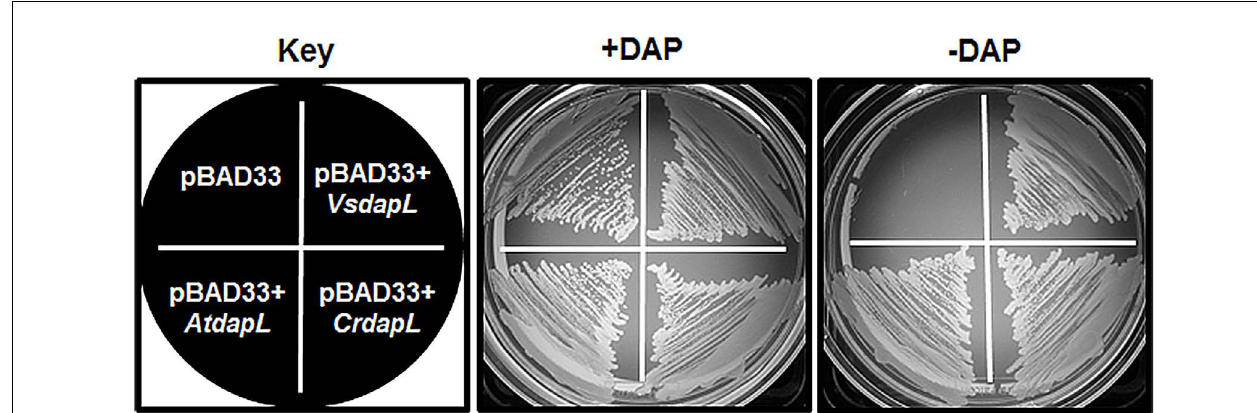
FIGURE 4 | Functional complementation of E. coli Δ dapD/dapE (AOH1) mutant. The AOH1 mutant harboring the plasmids pBAD33, pBAD33 + AtdapL , pBAD33 + CrdapL , and pBAD33 + VsdapL was replica-plated on LB medium supplemented with 0.2% (w/v) arabinose with or without 50 μ g/mL L,L -diaminopimelate. For presentation purposes only one colony from the vector only and recombinant plasmids are represented in the diagram.